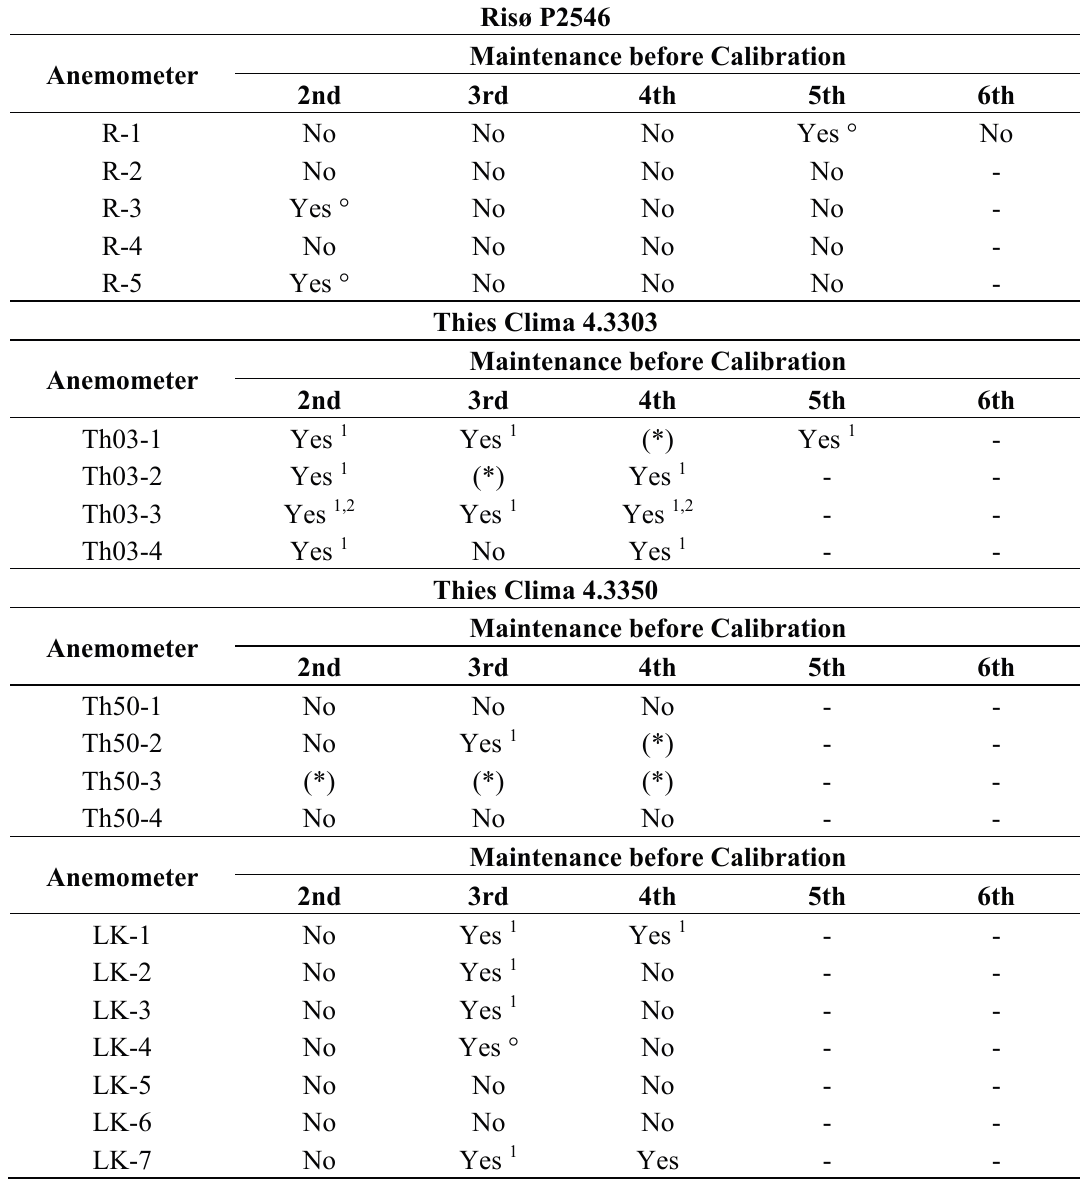
Table 2. Maintenance works performed on anemometers calibrated several times at the IDR/UPM Institute. See also Figure